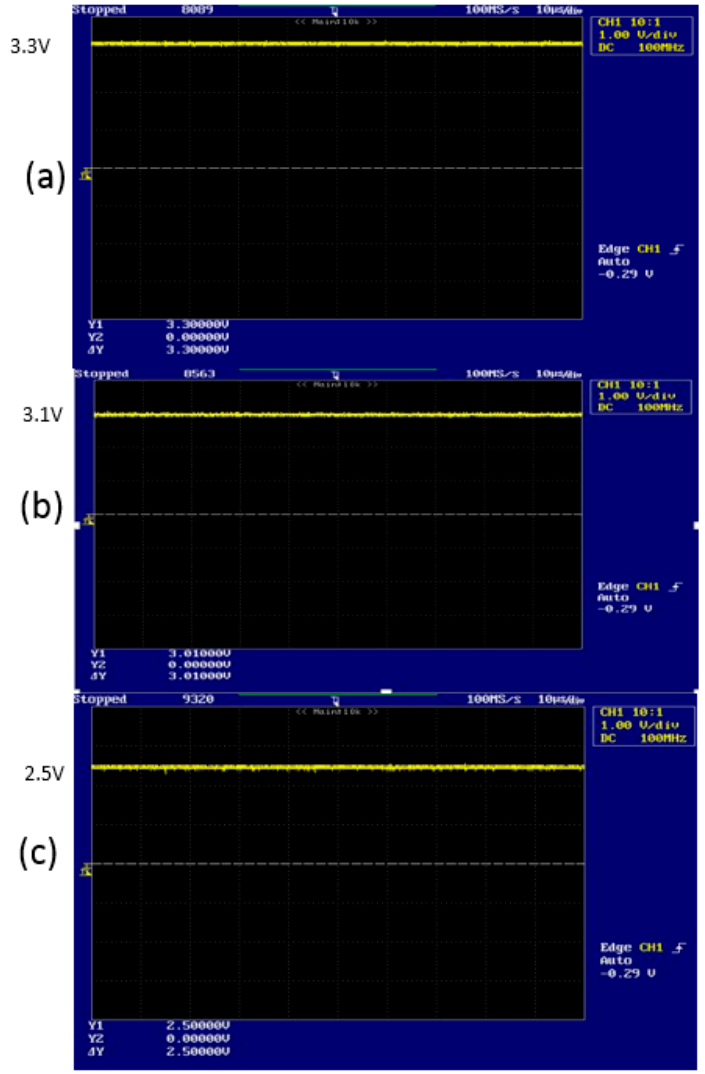
Figure 9. DC-offset output voltage shown as: ( a ) DC 3.3 V; ( b ) DC 3.1 V; and ( c ) DC 2.5 V, respectively, for when the strength of radiation of reflective laser beam are: ( a ) none; ( b ) weak; and ( c )